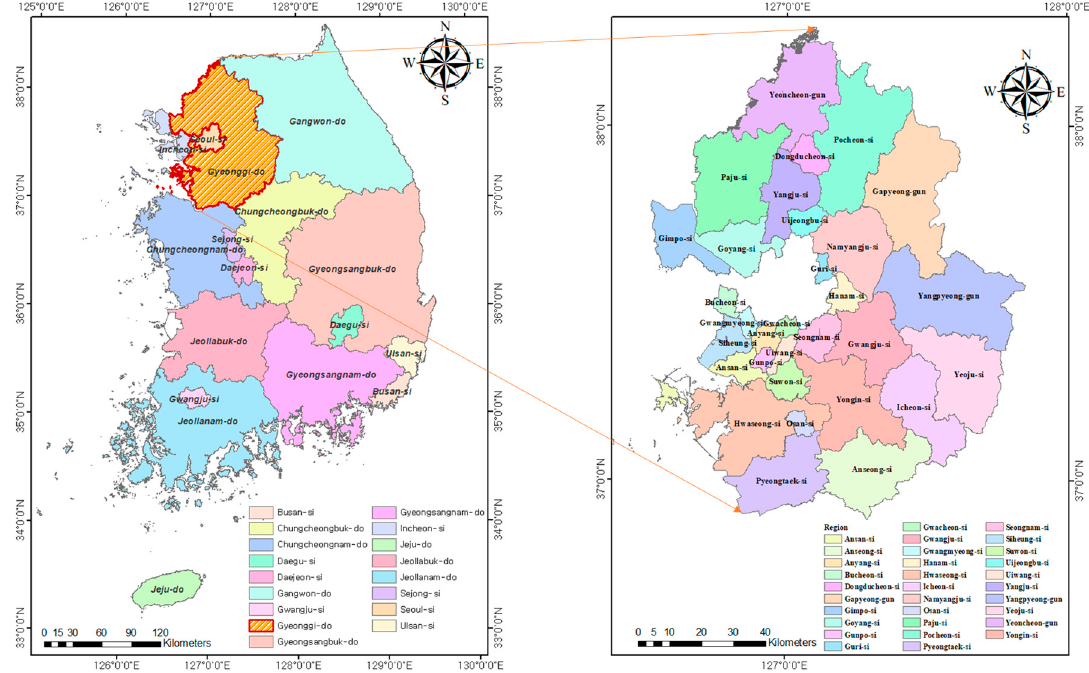
Figure 2. Study area (Gyeonggi province in South Korea).